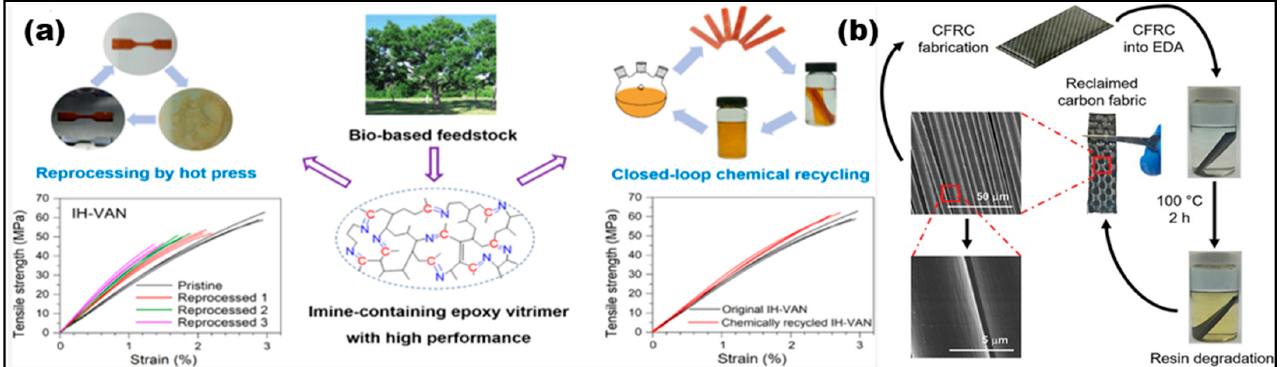
Figure 13. ( a ) Mechanically and chemically closed-loop recycling process and stress-strain curves of the cured biomass vanillin-modified themosets [18]; ( b ) schematic diagram of the complete reprocessing method of CFRCs and morphology of the surface of the recovered carbon fiber [reproduced with permission from Memon et al.; published by Elsevier, 2020] [80].